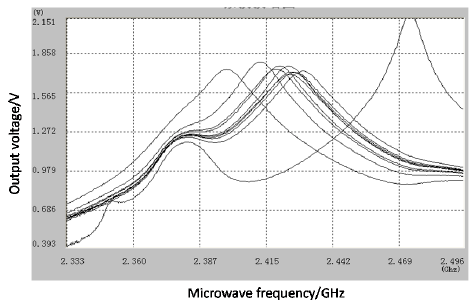
Figure 6. Microwave spectra of microwave absorbing characteristics for non-magnetic products.